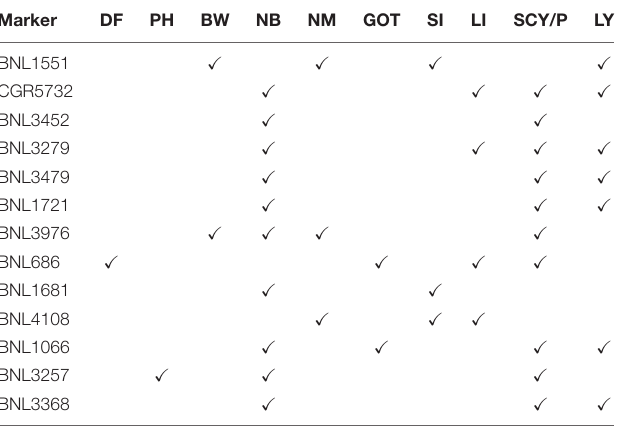
TABLE 4 | List of markers having linkage and pleiotropic effect (i.e., significantly associated to two or more traits). Marker DF PH